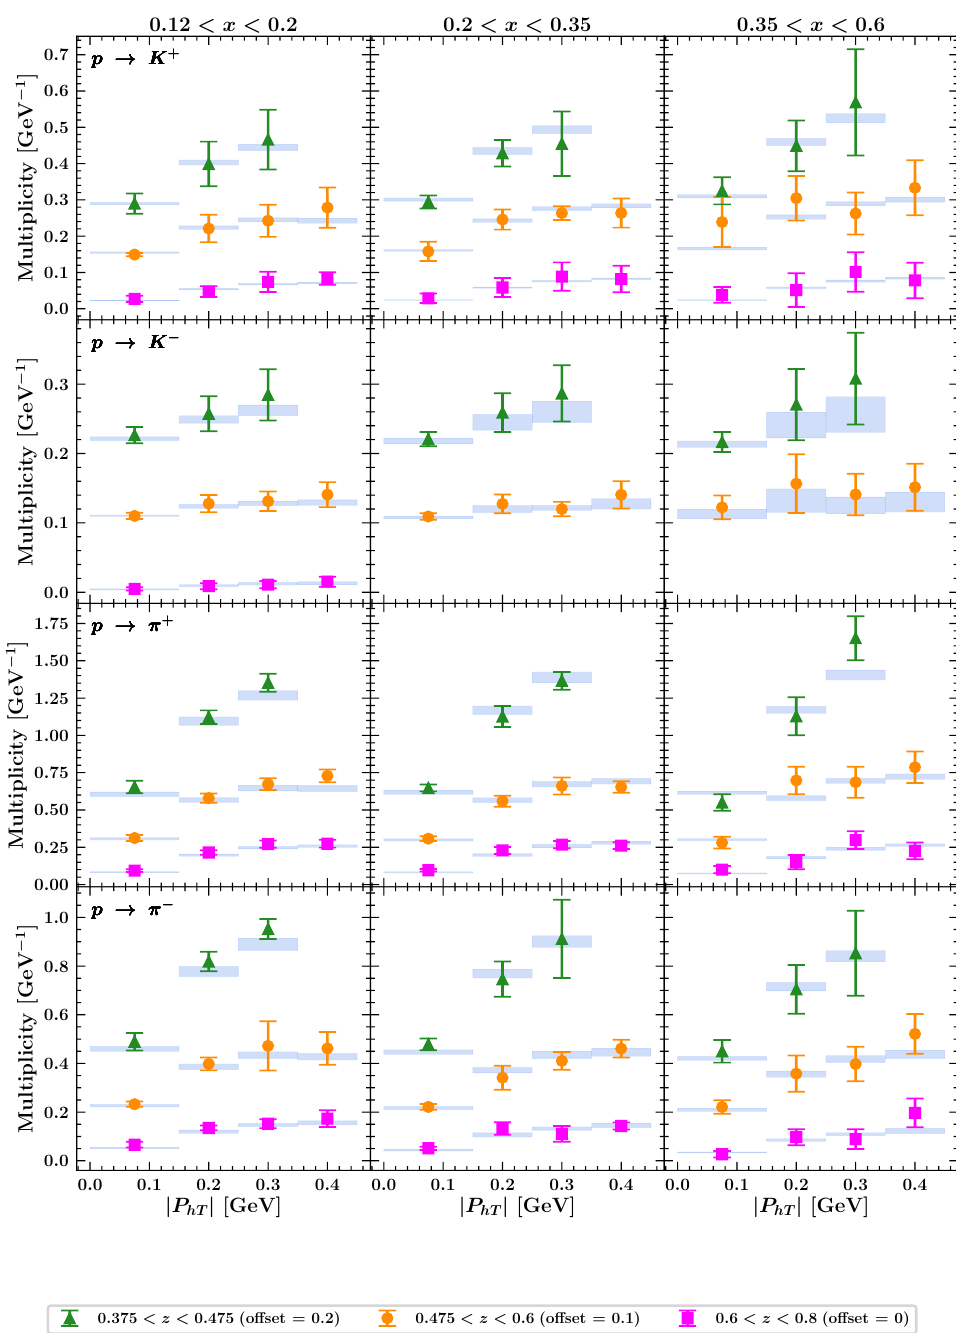
Figure 5 . Same conventions and notation as in previous figure but for charged pions and kaons off proton